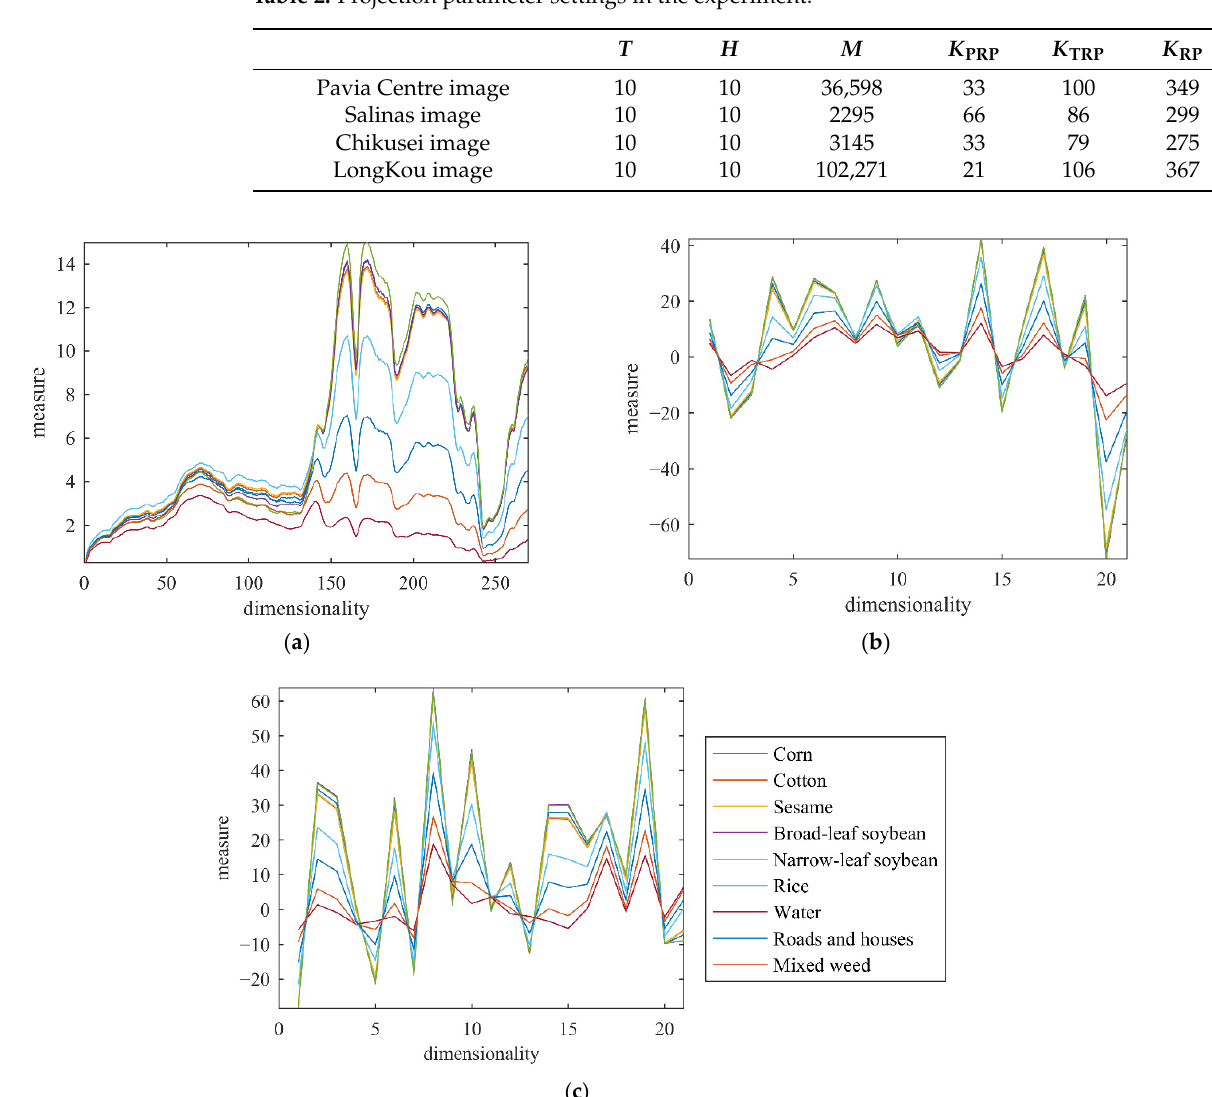
Figure 4. Spectral curve analysis of sample mean vectors of all classes in the LongKou image. ( a ) High dimensional sample mean vectors of all classes. ( b ) Low dimensional sample mean vectors of all classes after dimensionality reduction without projection matrix selection. ( c ) Low dimensional sample mean vectors of all classes after dimensionality reduction based on projection matrix selection, with legends for all